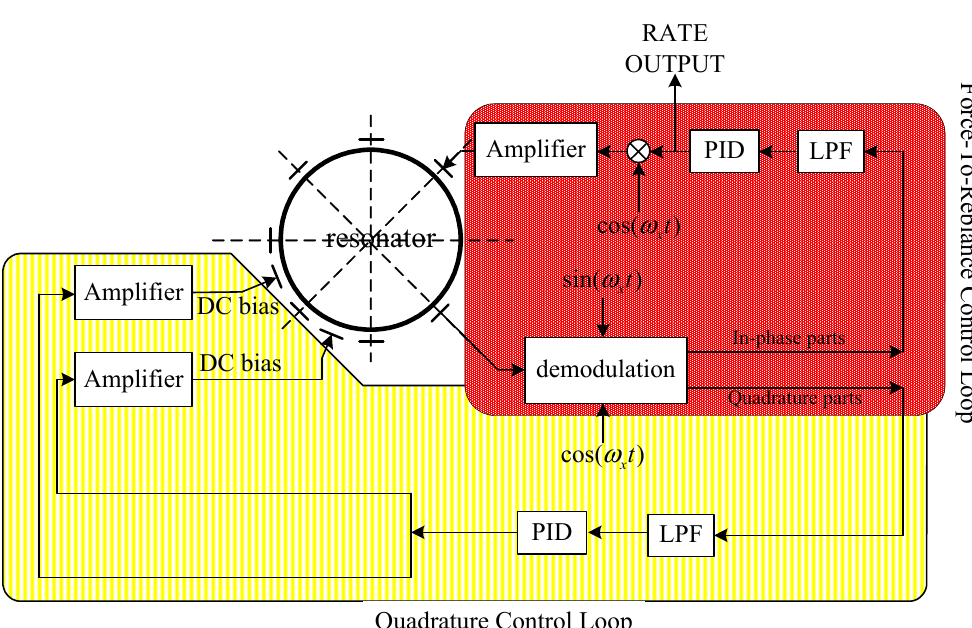
Figure 4. Secondary control loops of the HRG including Quadrature Control Loop and Rebalance Control